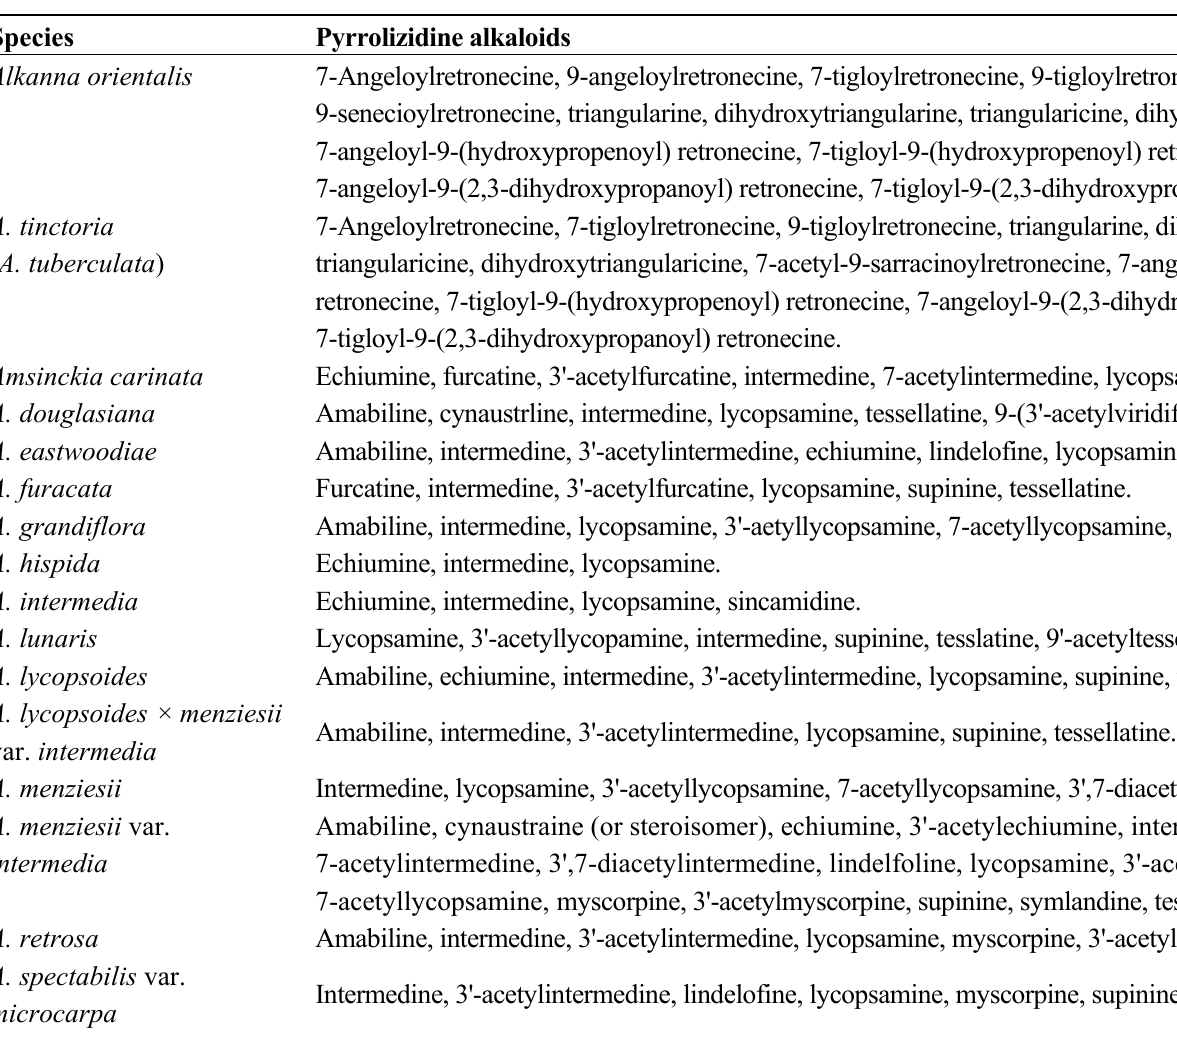
Table 1. List of plant species of the Boraginaceae containing